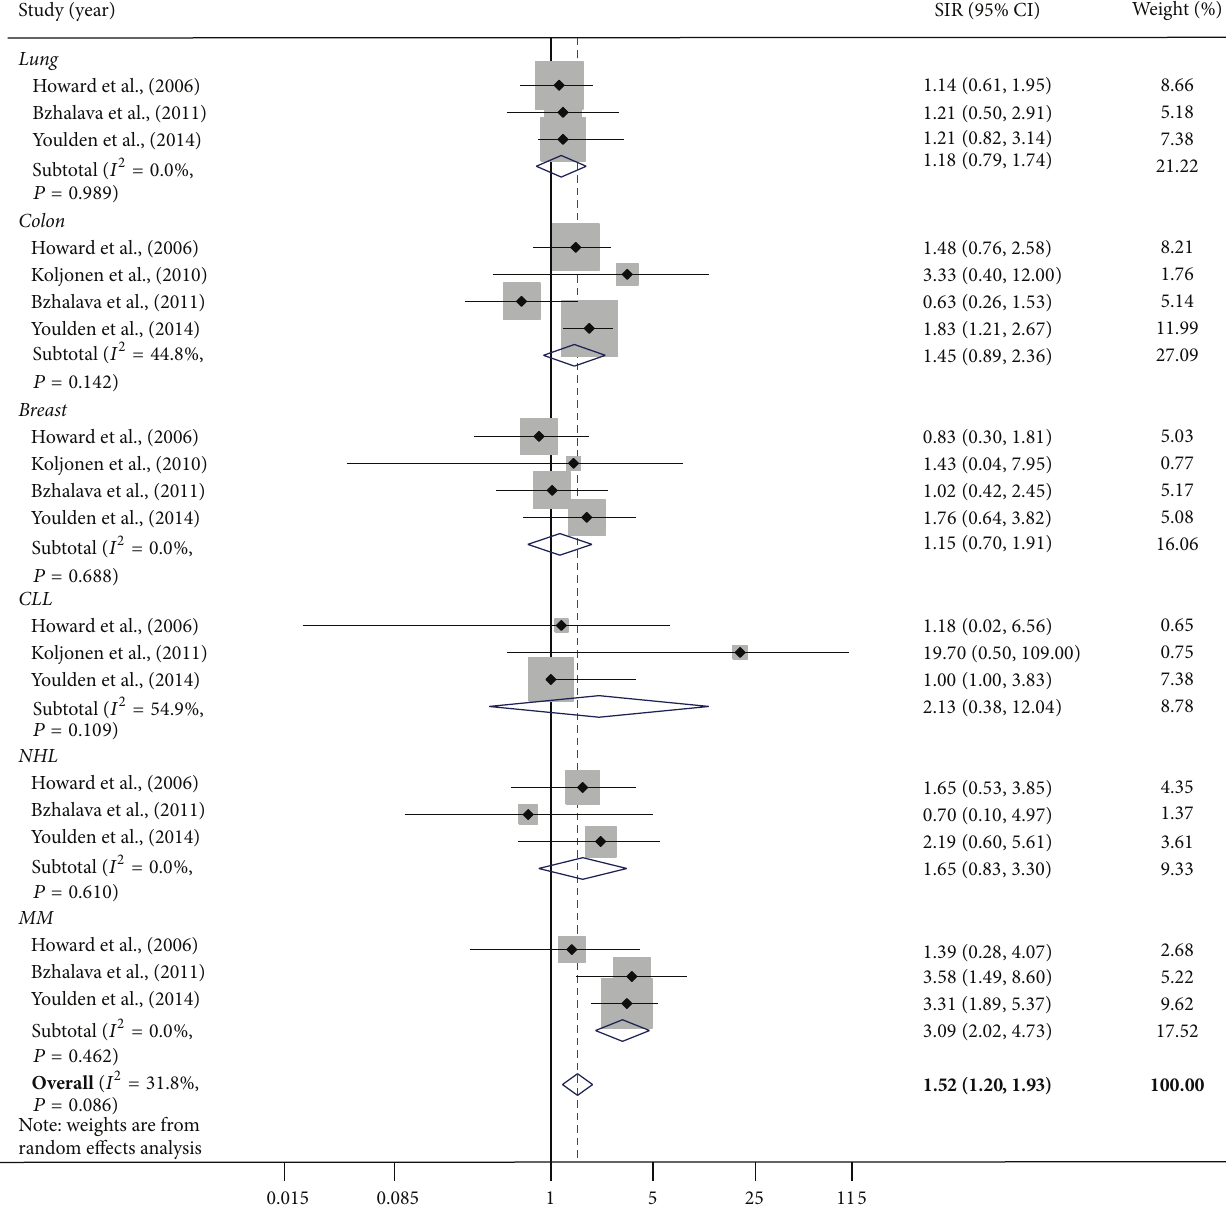
Figure 3: Risk of second cancer after one year of MCC diagnosis. Squares indicate the odds ratios for the individual studies; horizontal lines indicate the 95% confidence interval. The size of the data marker corresponds to the relative weight assigned in the pooled analysis using the random effects model. Diamond indicates the pooled odds ratios with 95% confidence interval. NHL: non-Hodgkin’s lymphoma; CLL: chronic lymphocytic lymphoma; MM: malignant